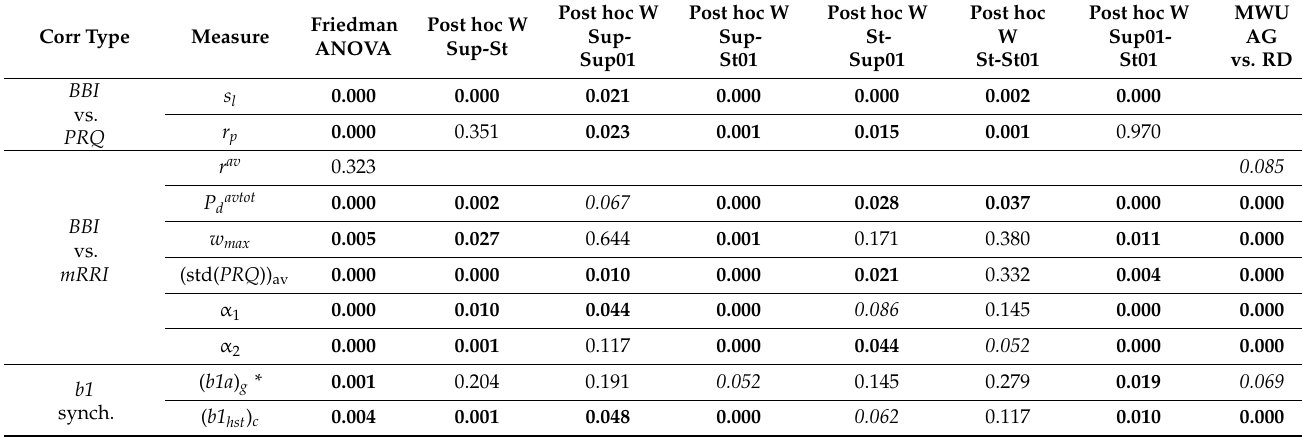
Table 1. Summarized results of the statistical